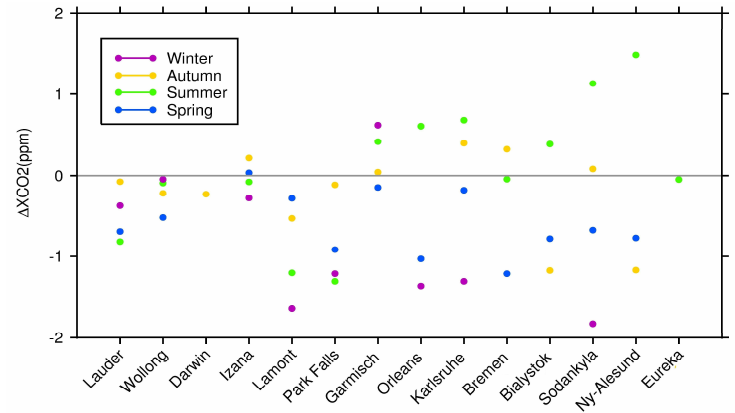
Figure 11. Variations of seasonal biases between GEOS-Chem and TCCON sites during March 2010–December 2011: MAM, blue; JJA, green; SON; yellow and DJF, purple.